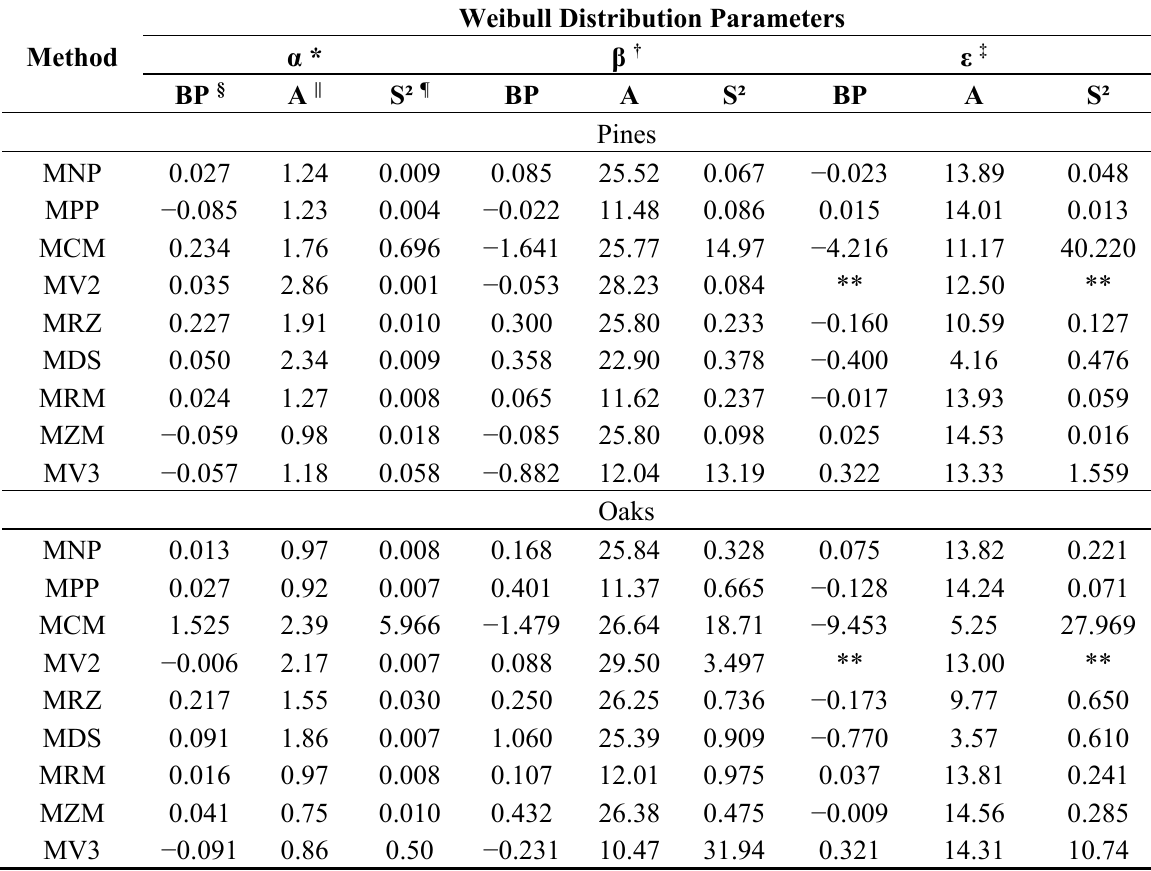
Table 3. Efficiency and consistency of parameter estimators for α , β and ε calculated by nine methods for pines and oaks in mixed forest stands of Durango,